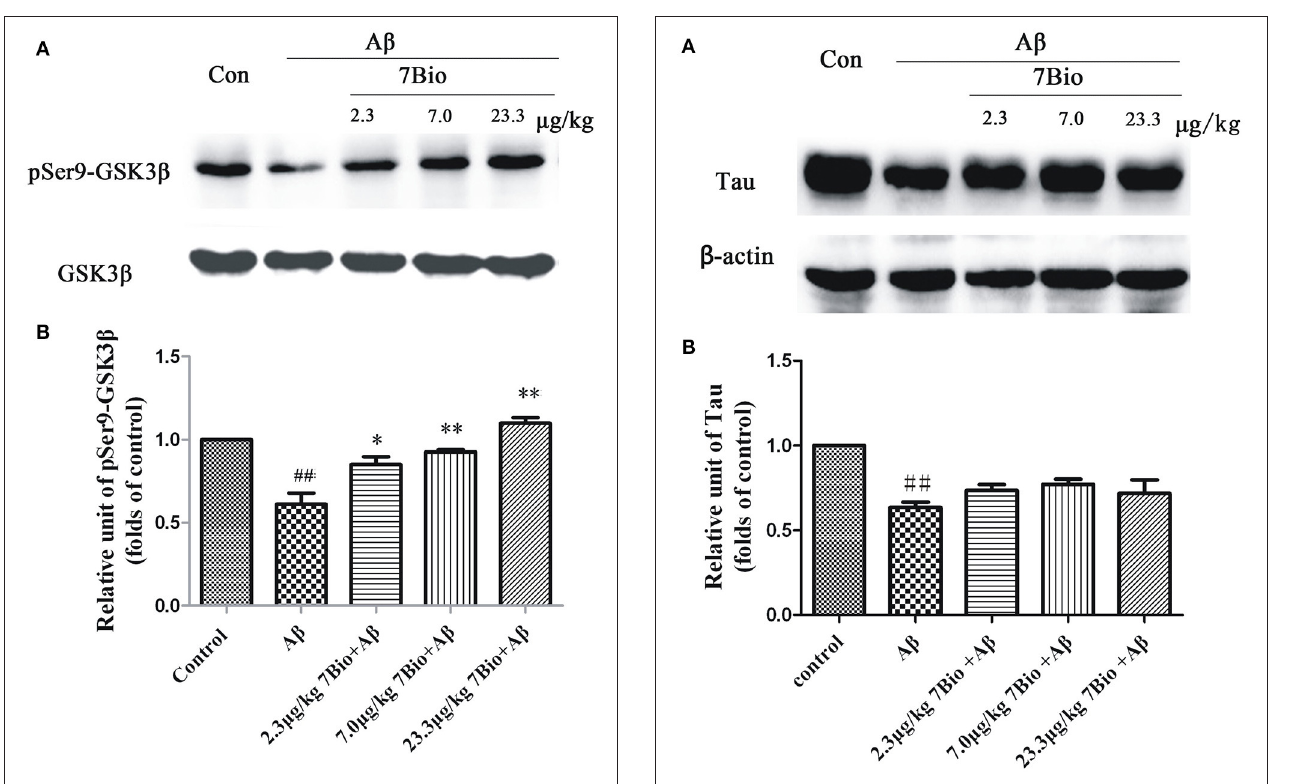
FIGURE 12 | 7Bio attenuates A β oligomer-induced decrease expression of pSer9-GSK3 β in the hippocampal region of mice. At day 19 post-surgery, mice were sacrificed. (A) The expressions of pSer9-GSK3 β and GSK3 β in the hippocampus were evaluated by Western blotting analysis. The quantitative analysis of levels of pSer9-GSK3 β was shown in (B) . Data represent the mean ± SD ( n = 4); ## p < 0.01 vs. control group, * p < 0.05 and ** p < 0.01 vs. A β group (one-way ANOVA and Tukey’s test).